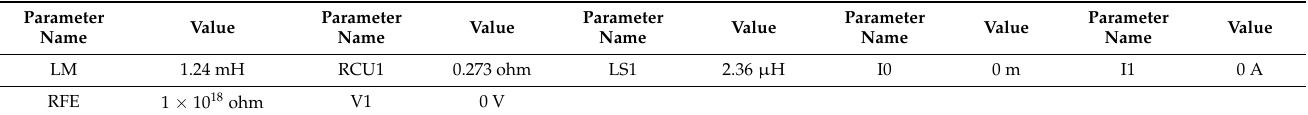
Table A7. Electrical parameters of the transformer, primary side—TFR2P1_1 from Figure